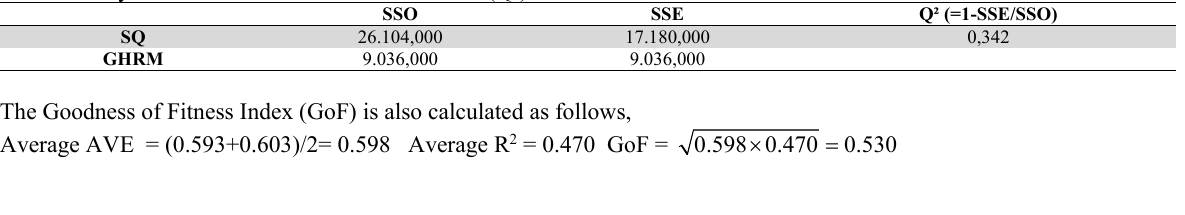
SSO SSE Q² (=1-SSE/SSO)